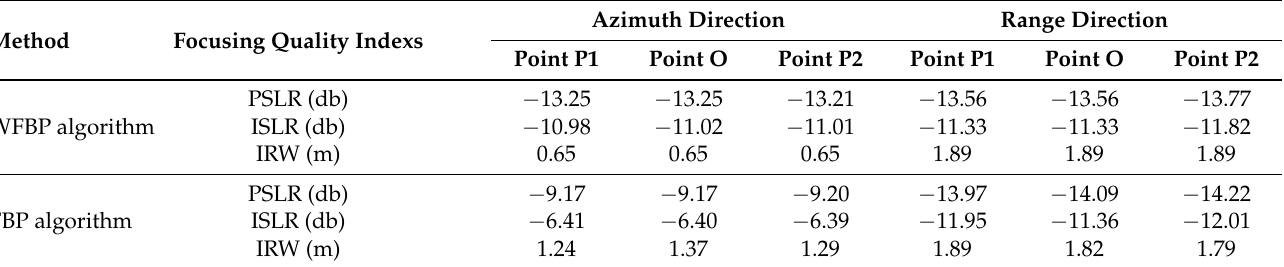
Figure 13. Detailed imaging results by the WFBP and the FBP under the bistatic forward-looking model. ( a ) P1 point imaging results obtained by the WFBP algorithm; ( b ) P1 point imaging results obtained by the FBP algorithm; ( c ) O point imaging results obtained by the WFBP algorithm; ( d ) O point imaging results obtained by the FBP algorithm; ( e ) P2 point imaging results obtained by the WFBP algorithm; ( f ) P2 point imaging results obtained by the FBP algorithm. Table 4. Comparison of focusing results between the WFBP and FBP algorithms.